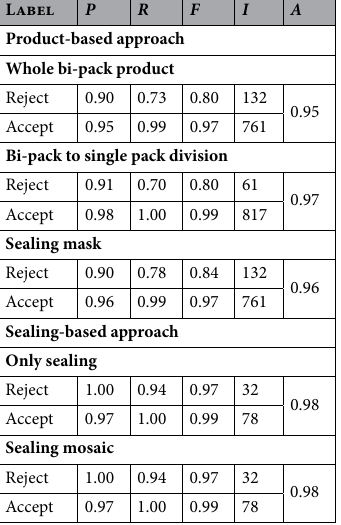
Table 3. Evaluation of the five different domain-specific datasets using a pre-trained ResNet18, where P , R , F , I, and A correspond to precision, recall, F-score, number of images used, and accuracy,